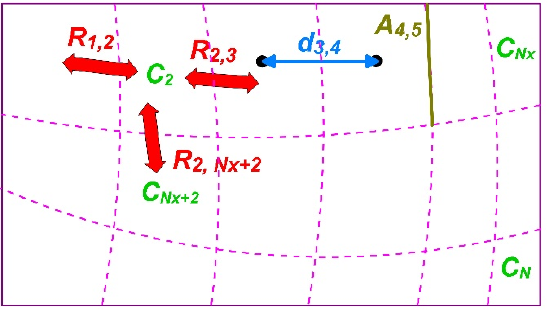
Figure 1. Arrangement of the generalized variables for the case when the mesh is not necessarily regular. The red double arrows are for conduction between cells with capacities C i and C j through the resistances R ij .